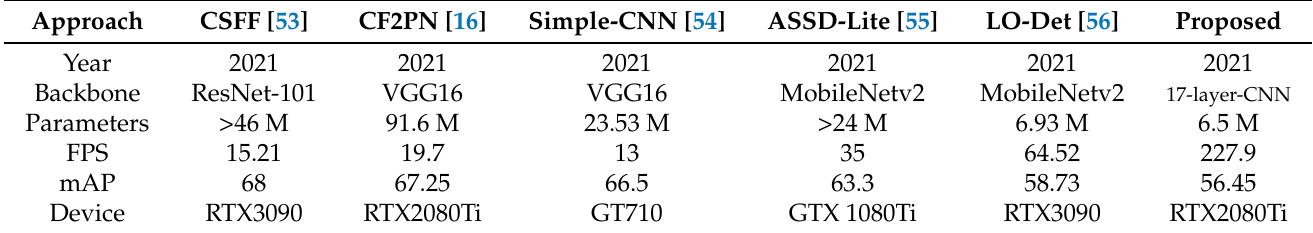
Table 13. Comparison with state-of-the-art detectors for remote sensing images. The performance data were measured on the DIOR